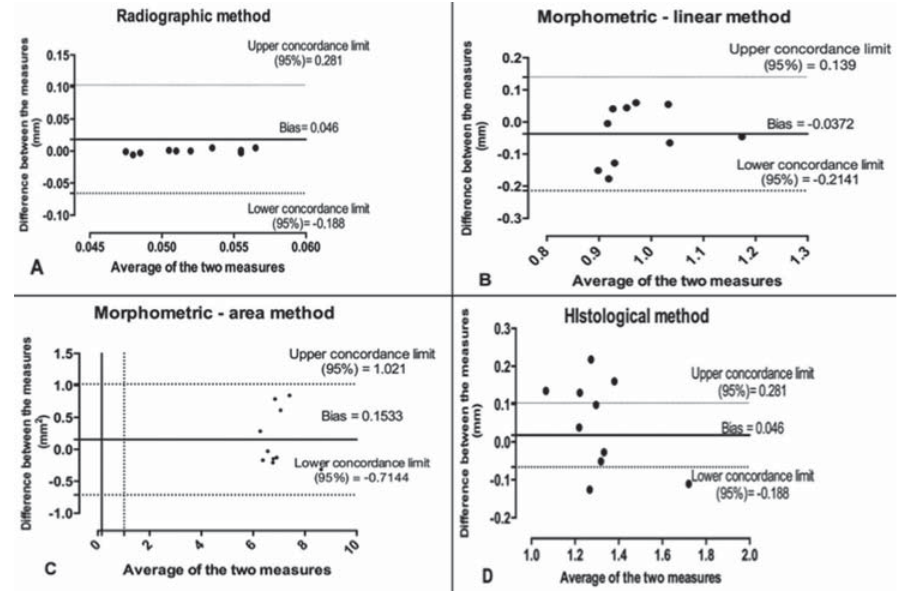
Figure 5- (cid:3)(cid:37)(cid:79)(cid:68)(cid:81)(cid:71)(cid:177)(cid:36)(cid:79)(cid:87)(cid:80)(cid:68)(cid:81)(cid:182)(cid:86)(cid:3)(cid:87)(cid:72)(cid:86)(cid:87)(cid:3)(cid:11)(cid:76)(cid:81)(cid:87)(cid:72)(cid:85)(cid:16)(cid:72)(cid:91)(cid:68)(cid:80)(cid:76)(cid:81)(cid:72)(cid:85)(cid:3)(cid:72)(cid:89)(cid:68)(cid:79)(cid:88)(cid:68)(cid:87)(cid:76)(cid:82)(cid:81)(cid:12)(cid:29)(cid:3)(cid:11)(cid:36)(cid:12)(cid:3)(cid:85)(cid:68)(cid:71)(cid:76)(cid:82)(cid:74)(cid:85)(cid:68)(cid:83)(cid:75)(cid:76)(cid:70)(cid:3)(cid:80)(cid:72)(cid:87)(cid:75)(cid:82)(cid:71)(cid:30)(cid:3)(cid:11)(cid:37)(cid:12)(cid:3)(cid:80)(cid:82)(cid:85)(cid:83)(cid:75)(cid:82)(cid:80)(cid:72)(cid:87)(cid:85)(cid:76)(cid:70)(cid:18)(cid:79)(cid:76)(cid:81)(cid:72)(cid:68)(cid:85)(cid:3)(cid:80)(cid:72)(cid:87)(cid:75)(cid:82)(cid:71)(cid:30)(cid:3)(cid:11)(cid:38)(cid:12)(cid:3)(cid:80)(cid:82)(cid:85)(cid:83)(cid:75)(cid:82)(cid:80)(cid:72)(cid:87)(cid:85)(cid:76)(cid:70)(cid:18) (cid:68)(cid:85)(cid:72)(cid:68)(cid:3)(cid:80)(cid:72)(cid:87)(cid:75)(cid:82)(cid:71)(cid:30)(cid:3)(cid:68)(cid:81)(cid:71)(cid:3)(cid:11)(cid:39)(cid:12)(cid:3)(cid:75)(cid:76)(cid:86)(cid:87)(cid:82)(cid:79)(cid:82)(cid:74)(cid:76)(cid:70)(cid:68)(cid:79)(cid:3)(cid:80)(cid:72)(cid:87)(cid:75)(cid:82)(cid:71) Table 1- Pearson’s correlation ( r 2 ) between the Radiographic Morphometric/linear Morphometric/area Histological Radiographic - Morphometric/linear Morphometric/area